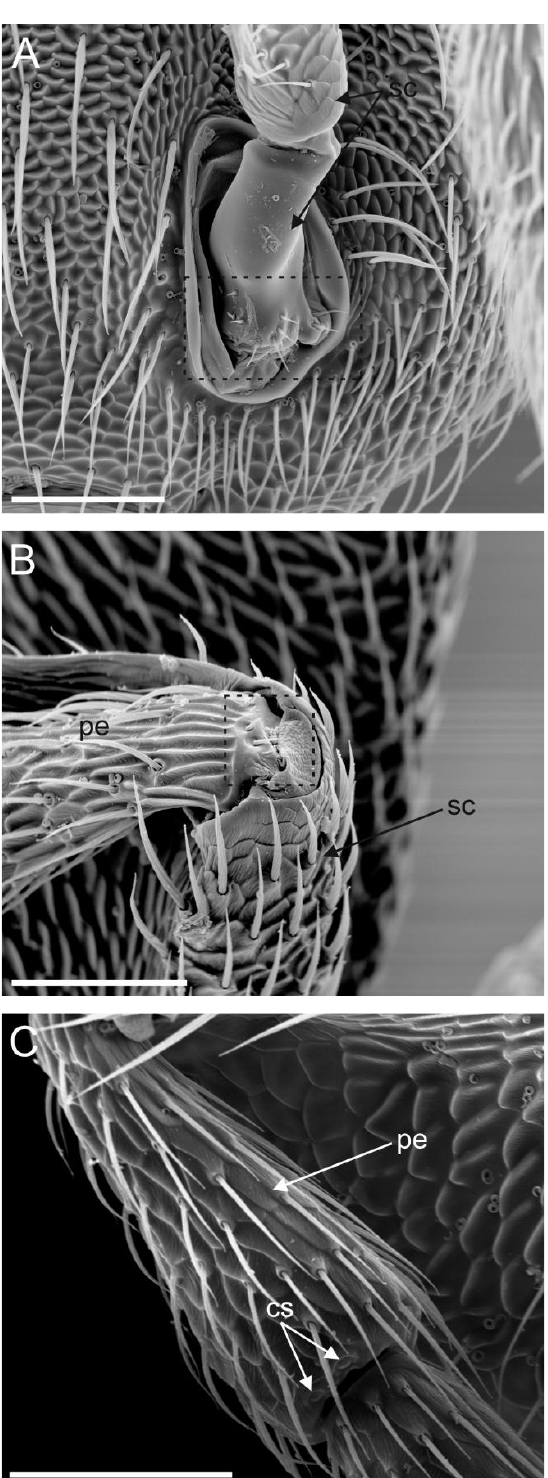
Figure 2. Scanning electron microscopy (SEM) of the Anagyrus vladimiri female antennae. ( A ) There is particular focus on the antenna articulation base at the head capsule. The base of the scape is connected with the torulus. The dotted square shows the area where mechanosensory hairs are positioned. ( B ) Detail of the scape (sc)–pedicel (pe) joint; at this level, a few mechanosensory hairs are located near the articulation joint (dotted square). ( C ) Lateral view of the pedicel (pe): two campaniform sensilla (CS) are positioned at the distal end of the antennomere. Scale bar: ( A , C ): 50 µm; ( B ): 40 µm.